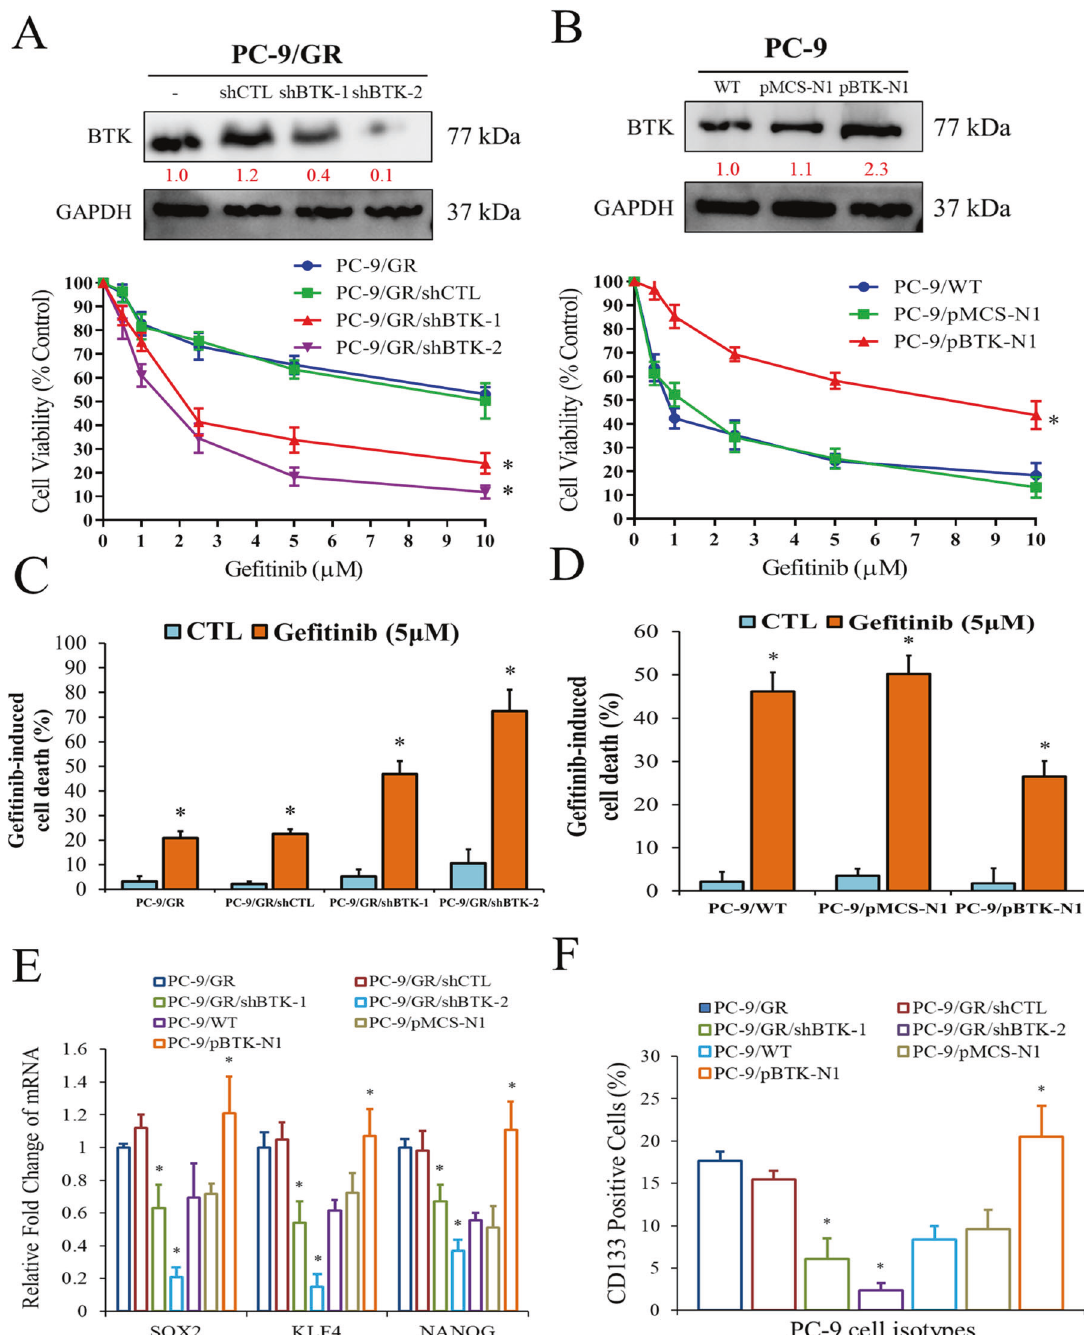
Fig. 4 BTK is required for Ge fi tinib-induced cell death probably regulated by stemness. A Cell viability evaluated by SRB assay in PC-9/GR, PC-9/GR/shCTL, PC-9/GR/shBTK-1, and PC-9/GR/shBTK-2 cells. B Cell viability evaluated by SRB assay in PC-9 (wild type), PC-9/pMCS-N1 (vector control), and PC-9/pBTK-N1 (BTK overexpression) cells. C Cell apoptosis determined by fl ow cytometry after treatment of 5 μ M Ge fi tinib in PC- 9/GR, PC-9/GR/shCTL, PC-9/GR/shBTK-1, and PC-9/GR/shBTK-2 cells. D Cell apoptosis determined by fl ow cytometry after treatment of 5 μ M Ge fi tinib in PC-9, PC-9/pMCS-N1, and PC-9/pBTK-N1 cells. E mRNA expression of KLF4, SOX2, and NANOG according to PC-9 cells with differed status of BTK expression and Ge fi tinib resistance. Total RNA was harvested for the analysis of mRNA by real-time RT-PCR. F CD133 + cells detected by fl ow cytometry according to PC-9 cells with different status of BTK expression and Ge fi tinib resistance. The results are shown as the means ± SD of three independent experiments, each performed in triplicate. CTL control, * p < DISCUSSION demonstrated that Acalabrutinib suppressed SOX2 and STAT3/ Most patients with NSCLC that receive EGFR TKIs experience JAK2/Akt axis, leading to decreased stemness and EMT in A549 disease progression as a result of acquired resistance within and PC-9 cells. The in vivo studies suggested that combination of approximately one year. The mechanisms of acquired resistance to Acalabrutinib and Osimertinib could effectively decrease tumor- EGFR TKIs have been gradually elucidated, and target gene igenesis of H1975 cells.